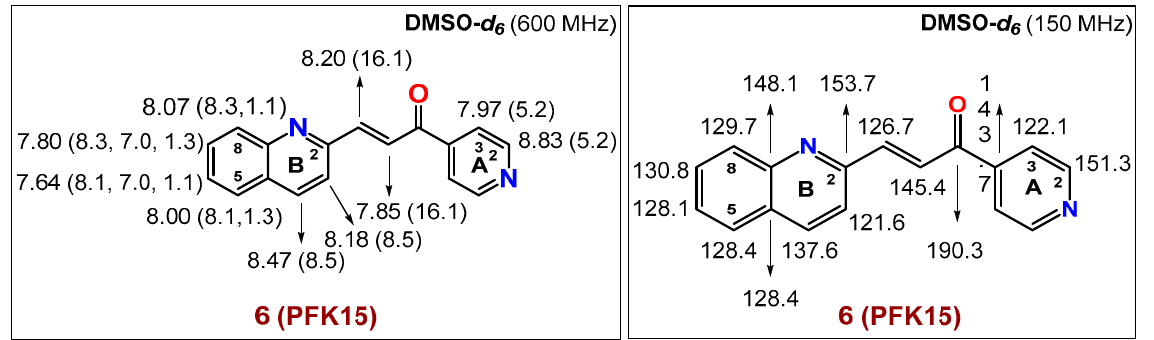
Figure 4. The spectral diagrams describing 1 H- and 13 C-NMR characteristics of 6 ( PFK15 ). 1 H-NMR (600 MHz, DMSO- d 6 ): δ 8.83 (d, 2H, J (A 2 ,A 3 ) = 5.2 Hz, 2 × H-C A (2)), 8.47